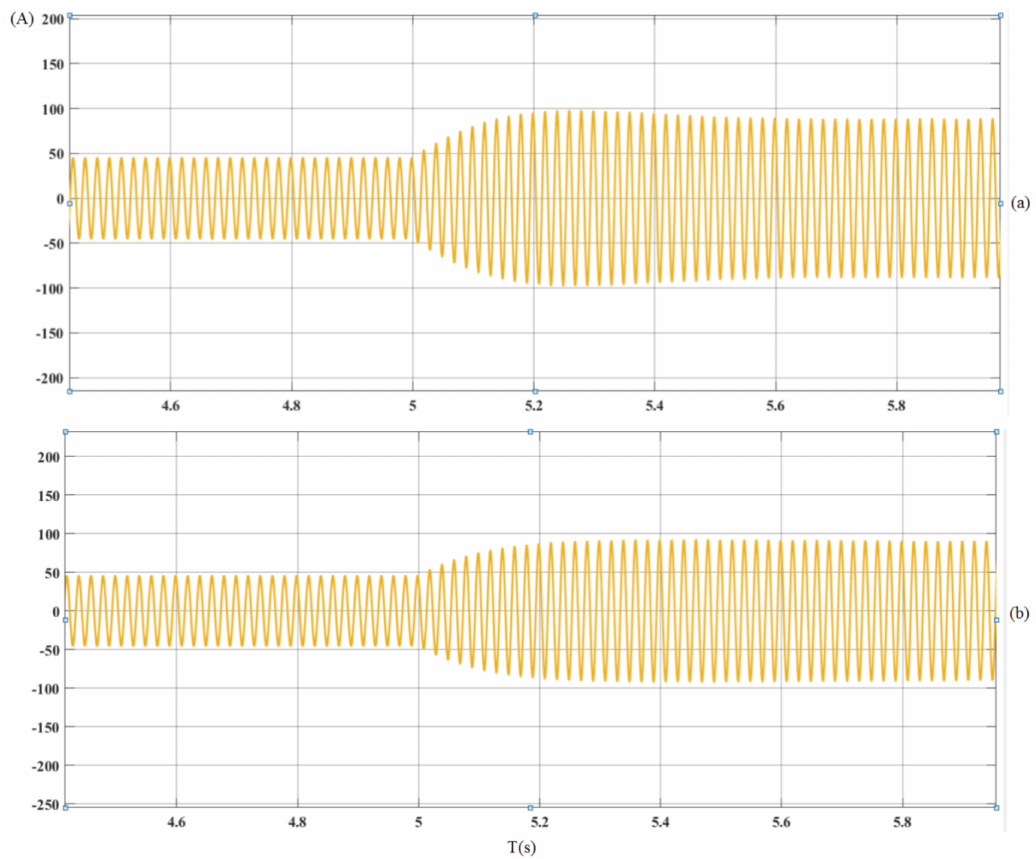
Figure 21. A-phase current waveforms when the load suddenly increases: ( a ) controlled by the direct power control method; ( b ) controlled by the nonlinear feed-forward PID control